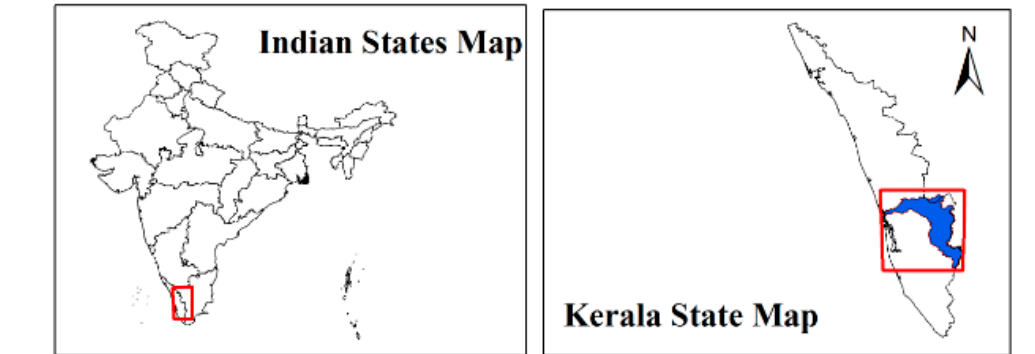
Figure 1. Study Area Showing Basin, Watershed, Reach, River Monitoring Point, and Gauge Discharge Station Locations. Normally the state has a dendritic type of drainage pattern in nature. The Periyar River splits into two streams at Alwaye, which outfalls into the Arabian Sea via two separate estuaries. The river is severely controlled by Idukki and Idamalayar reservoirs, built primarily for irrigation and power generation. The reservoirs’ geographical position is marked in Figure 1. The major reservoir of the basin is Idukki reservoir managed by three dams, i.e., Idukki dam, Kulamavu dam, and Cheruthoni dam. Amongst the different dams, the major dams are the Idamalayar and Idukki–Cheruthoni–Kulamavu trio. The Idamalayar and Periyar Valley Irrigation Project are the major irrigation projects in the basin.